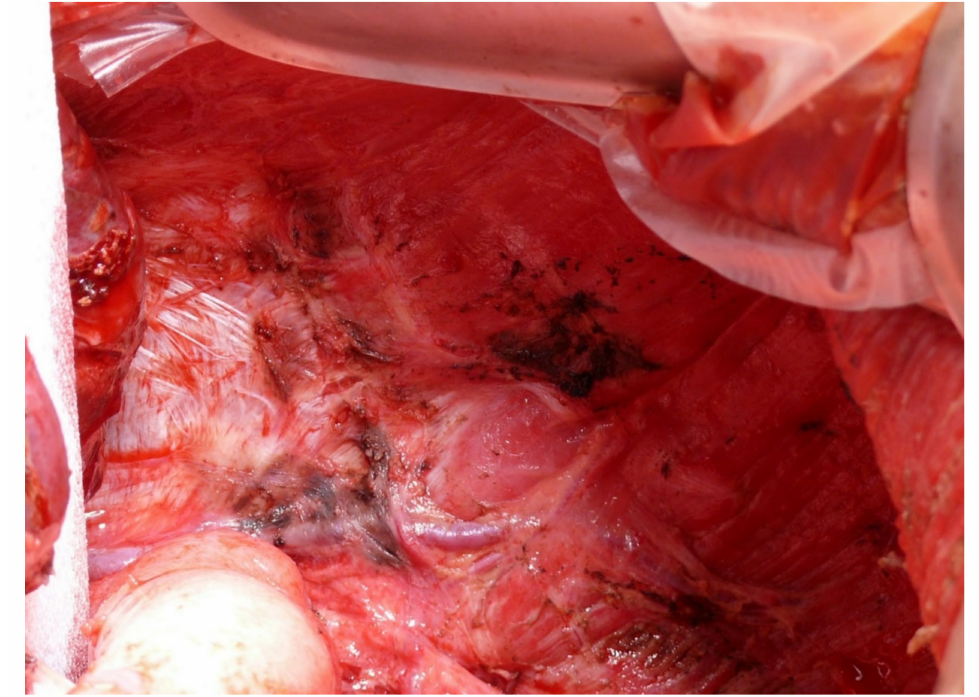
Figure 3. Dissected left diaphragm after parietal peritonectomy of the left upper quadrant. It is important to preserve the vessels and innervation intact, also not to enter the pleural